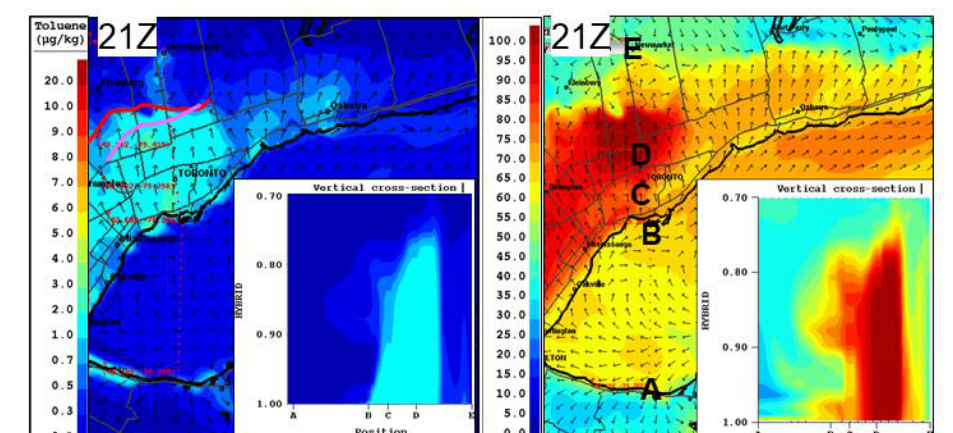
Figure 14. GEM-MACH-TEB predictions for air quality variables ( a ) NO x , ( b ) ozone, ( c ) toluene and mono-aromatics and ( d ) odd oxygen at 21:00 UTC 28 July 2015. The red and pink lines are the model- and measurement-derived lake-breeze fronts, respectively. Refer to Figure 13 for description of the hybrid vertical coordinate.